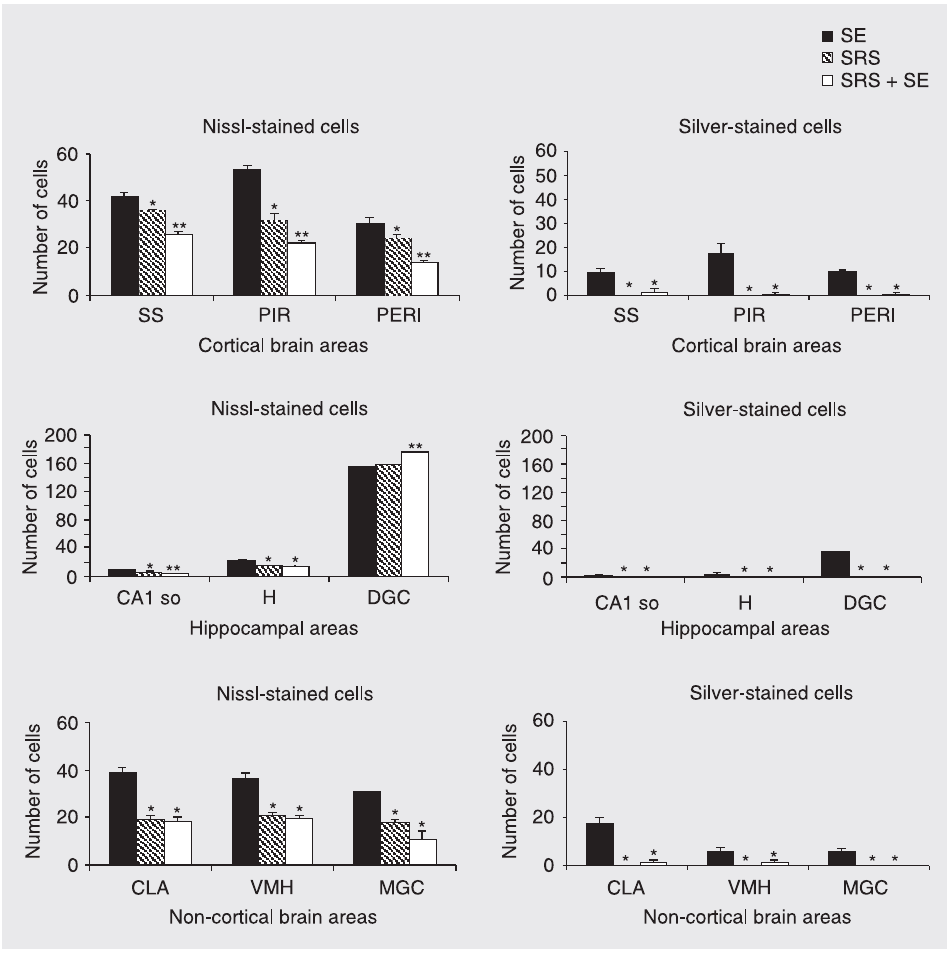
Figure 3. Cell counts of Nissl- and silver-stained sections for selected brain areas of the dif- ferent experimental groups.